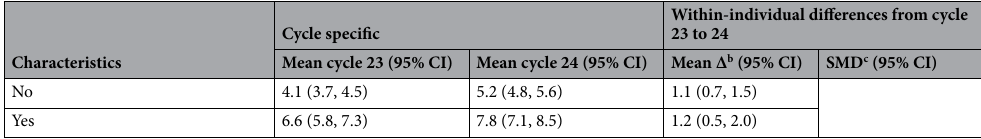
Table 2. Weighted a cycle-specific means, mean of within-individual differences (Δ) and standardized mean changes (SMD) for GAD-7 scores from cycle 23 to 24, Nicotine Dependence in Teens study, Québec, Canada 2017–2021, n = 673. a Weighted for non-response. b Represents individual differences between MDI or GAD-7 scores in cycle 24 and 23. c Represents differences in mean change between groups, divided by the within- group standard deviation averaged across cycle 23 and 24. 95% CIs were calculated using bootstrap resampling. SMD with 95% CI that excluded the null are in bold